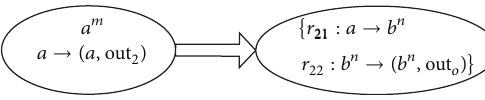
Figure 4: P chain system for